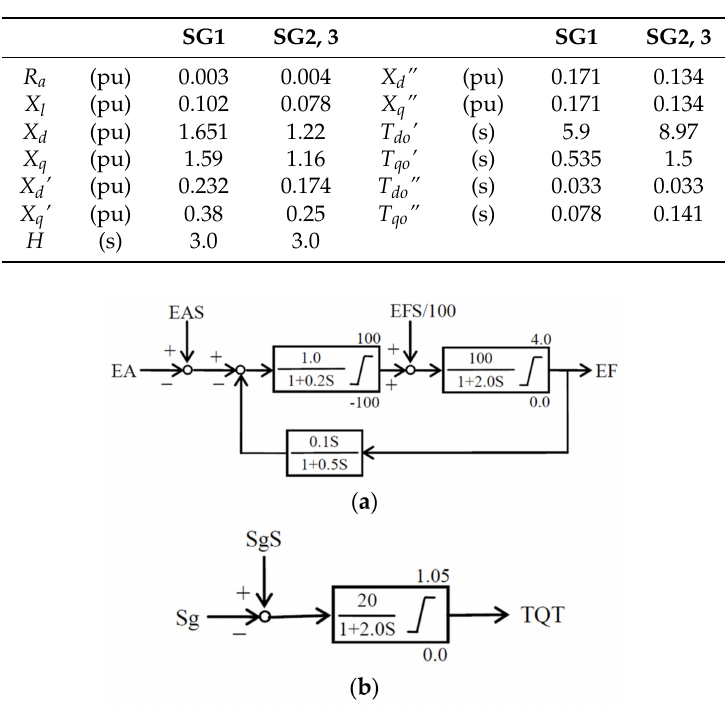
Table 1. SG parameters.